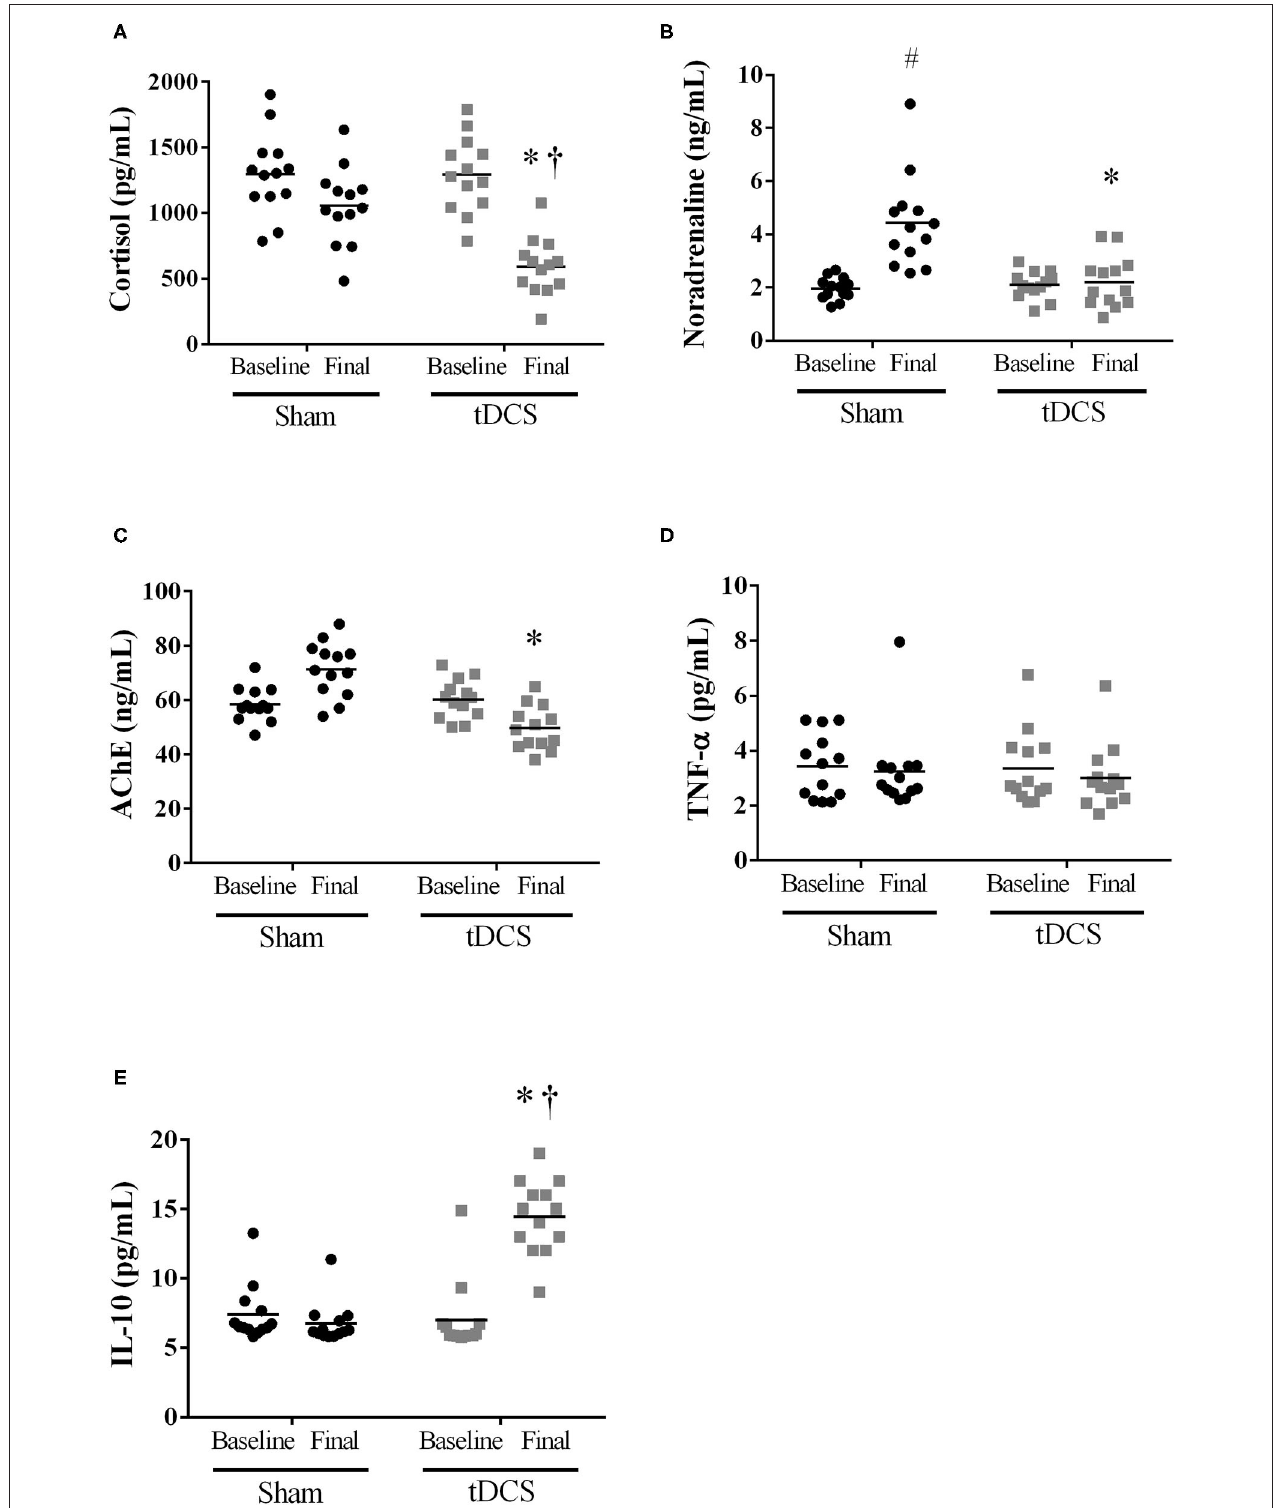
FIGURE 4 | Short-term intervention (10 sessions): Humoral mechanisms associated with BP regulation { (A) cortisol [ P = 0.0056 vs. SHAM; Interaction – P = 0.0072]; (B) noradrenaline [ P = 0.0004 vs. SHAM; Interaction – P < 0.0001]; (C) acetylcholinesterase [ P < 0.0001 vs. SHAM; Interaction – P < 0.0001]} and inflammatory cytokines { (D) TNF- α [P = 0.5774 vs. SHAM; Interaction – P = 0.8195], and (E) IL-10 [ P = 0.0053 vs. SHAM; Interaction – P = 0.0062]}. # Difference vs. SHAM baseline; † P < 0.05 vs. tDCS baseline; *Difference vs. SHAM at final moment.